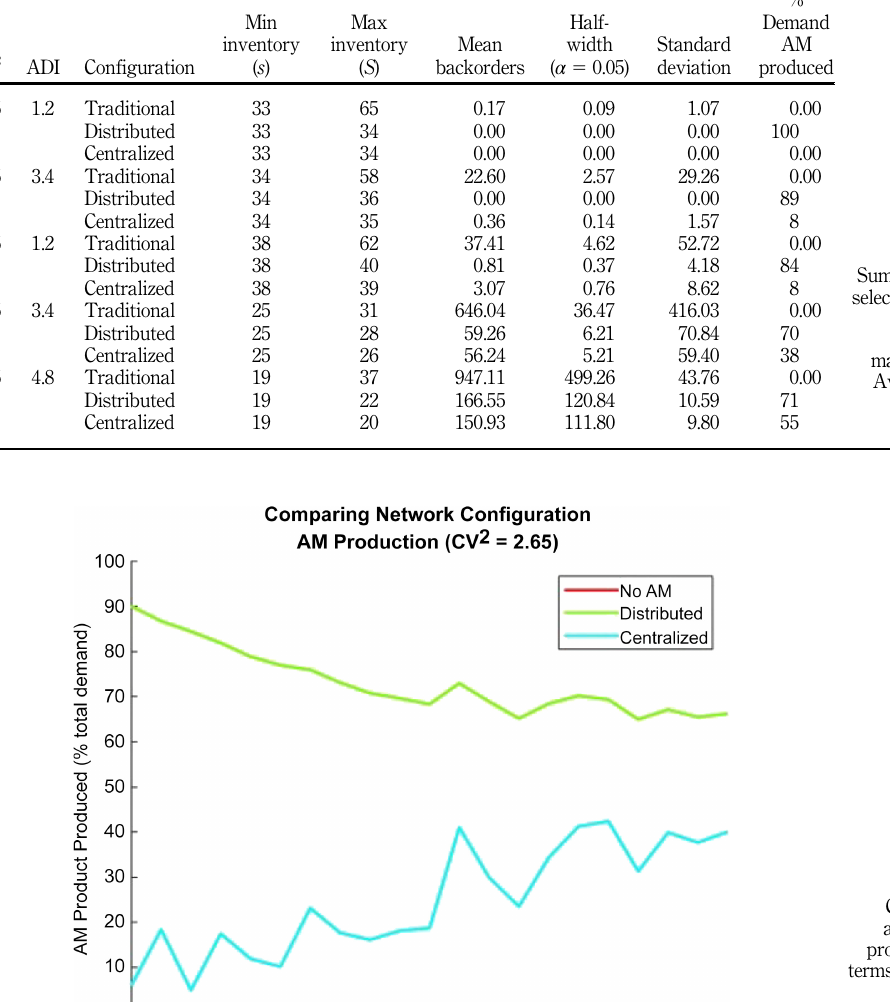
Comparison of the amount of product produced via AM (in termsofpercentoftotal demand) between